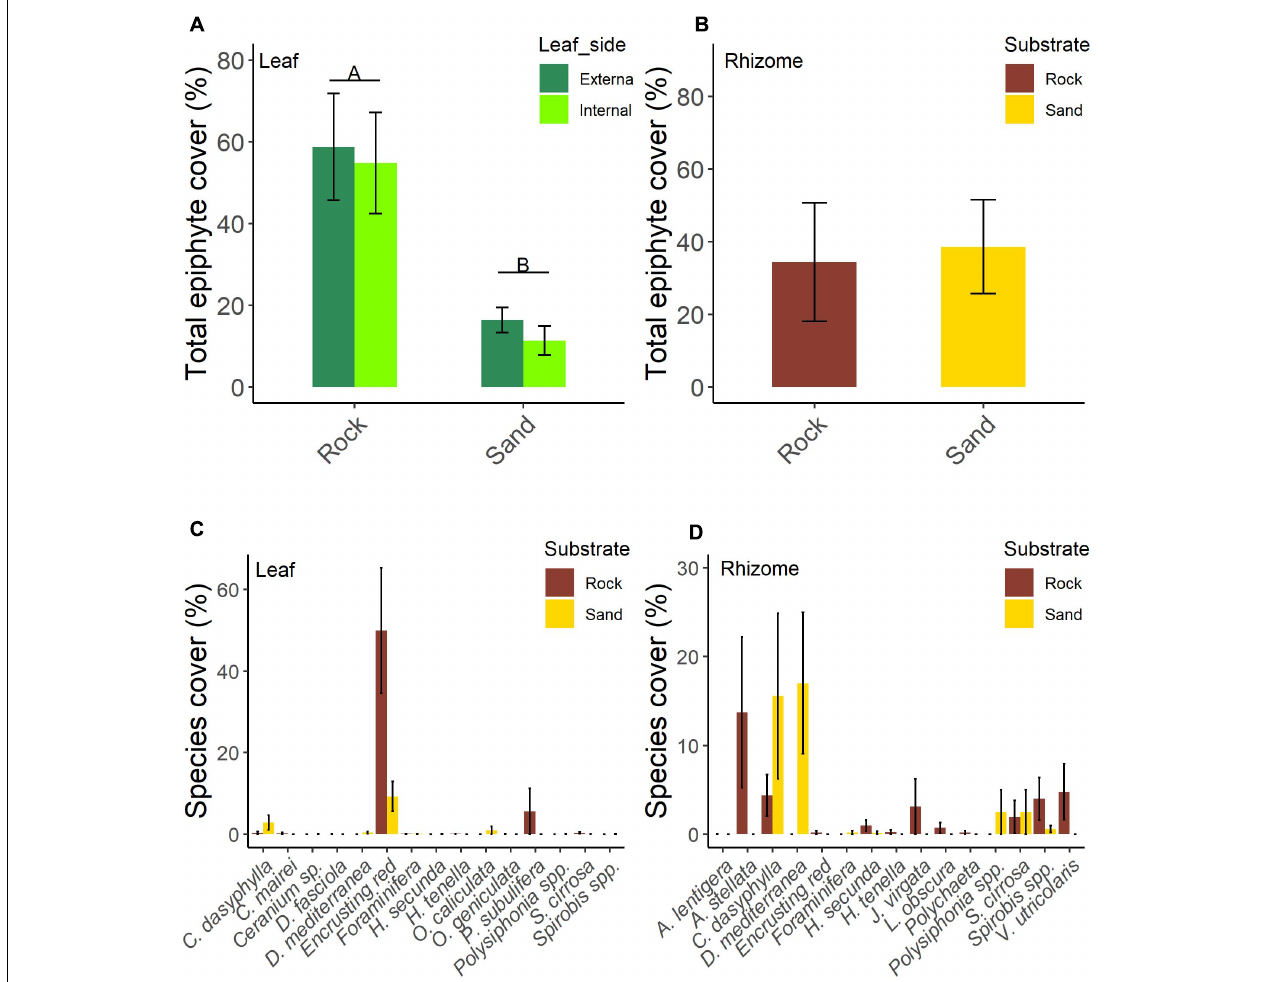
FIGURE 2 | Total epiphytic percentage cover of the two sides of leaves (A) and rhizomes (B) and epiphytic percentage cover of organisms of leaves [data are averaged for leaf sides; (C) ] and rhizomes (D) of five-year old seedlings of Posidonia oceanica grown on rock and sand substrate. Letters above bars denote significant differences between treatments at α < 0.01. Data are means ± SE; n =